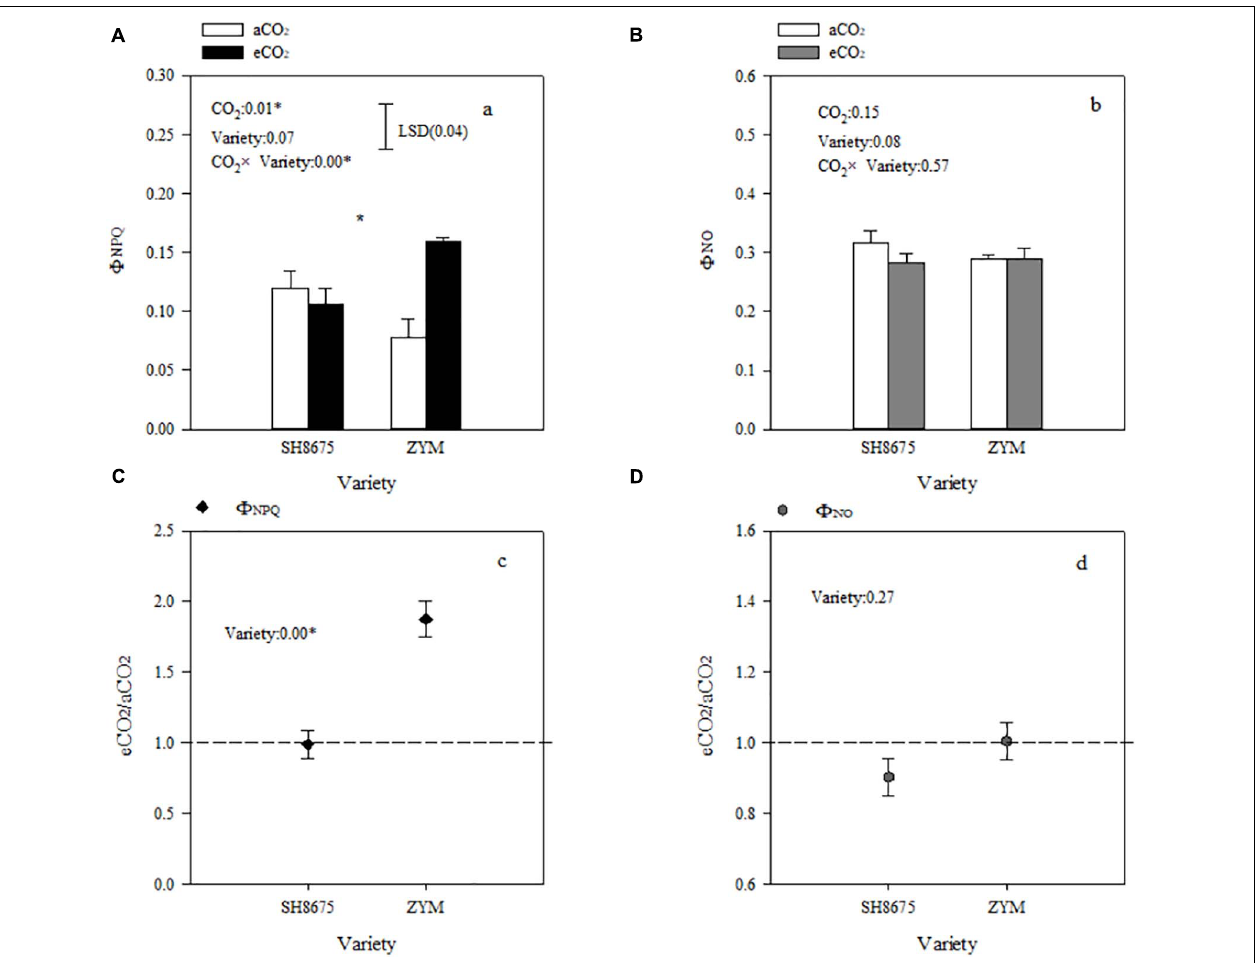
FIGURE 4 | Effects of elevated CO 2 on non-photochemical dissipation of two winter wheat varieties. Measurements were carried out on intact flag leaves. Data represent the mean of three plants from each variety plot ± SD (standard error) bars. ANOVA results with * indicate significance at p < 0.05. Vertical bars in (A,B) indicate LSD ( p < 0.05) for (cid:56) NPQ and (cid:56) NO , respectively. Differences of (cid:56) NPQ and (cid:56) NO between varieties in responses to eCO 2 are shown in (C,D) ,